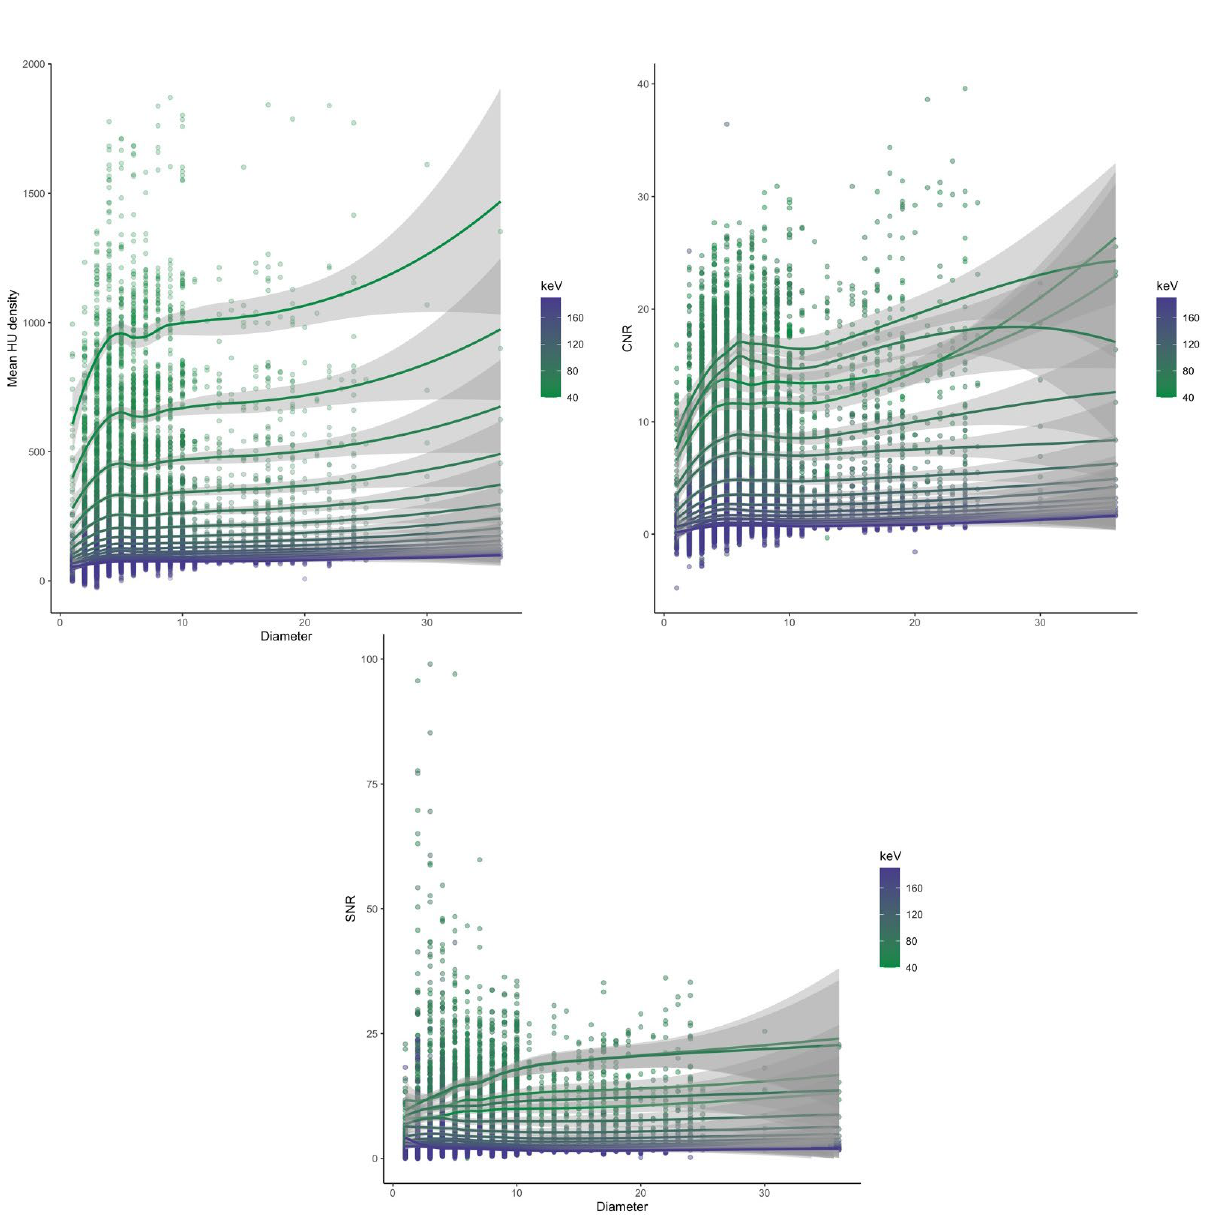
Figure 8. Scatterplots of the values of HU, CNR and SNR correlated with vessel diameter.